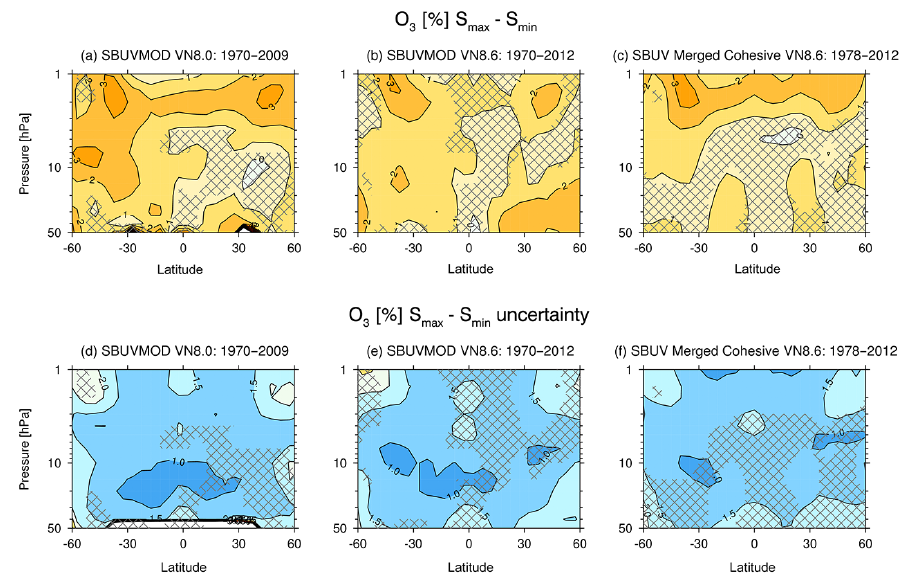
Figure 12. As in Fig. 10 for the (a, d) SBUVMOD VN8.0, (b, e) SBUVMOD VN8.6, and (c, f) SBUV Merged Cohesive VN8.6 datasets. SORs are derived for different periods as stated in the headers. The contour interval in panels (a–c) is 1% and 0.5% in panels (d–f)